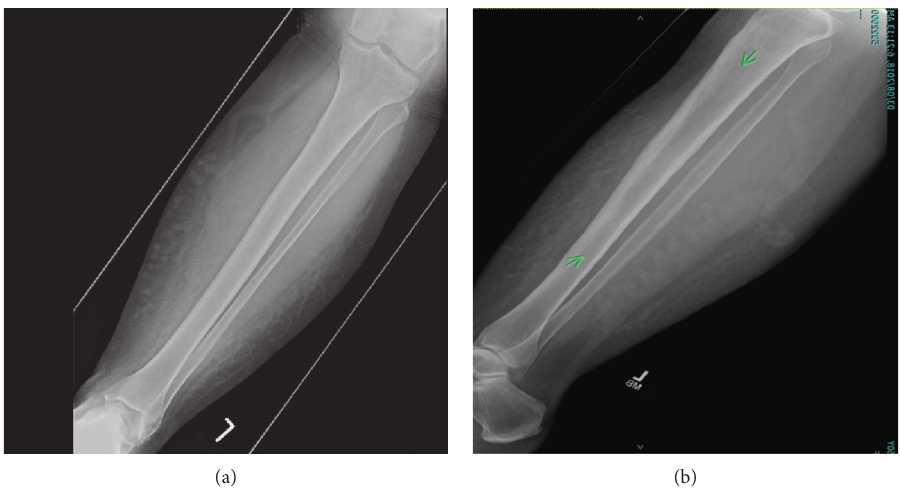
Figure 1: X-ray of the tibia fibula. (a) Antero-posterior (AP) view. (b) lateral view.